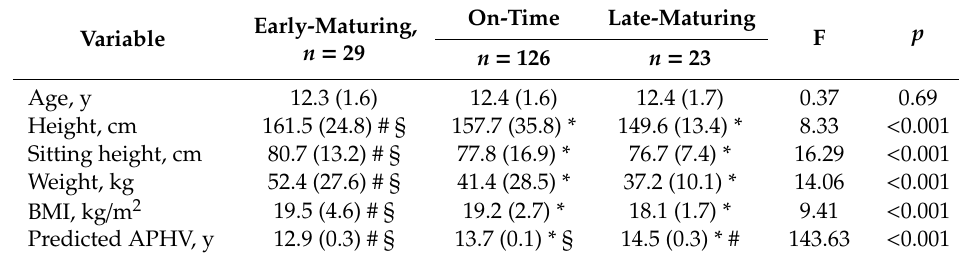
Table 1. Results of ANOVA analyses and descriptive statistics of anthropometric features, according to maturity status.